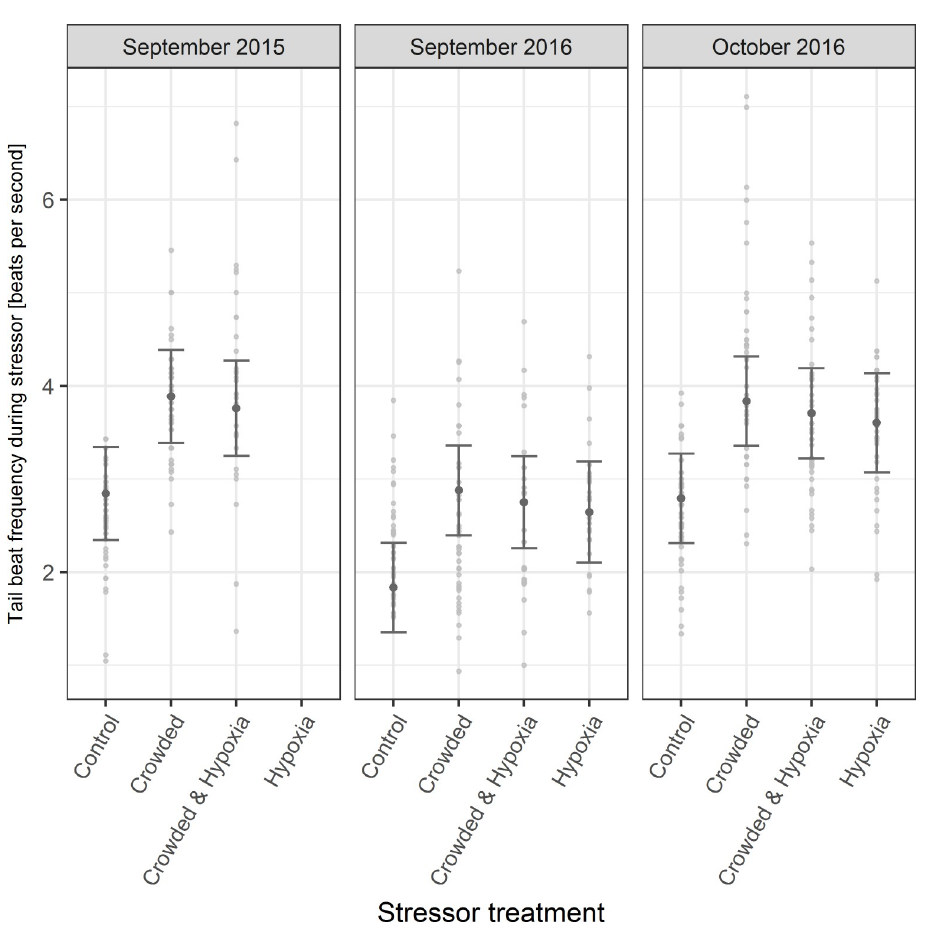
Fig 3. Tail beat frequency responses. Model predicted mean ( ± 95% confidence intervals) tail beat frequency during the application of the different stressors for the three experimental phases. No hypoxia treatment was applied during the September 2015 phase. The underlying raw data is shown as grey points.